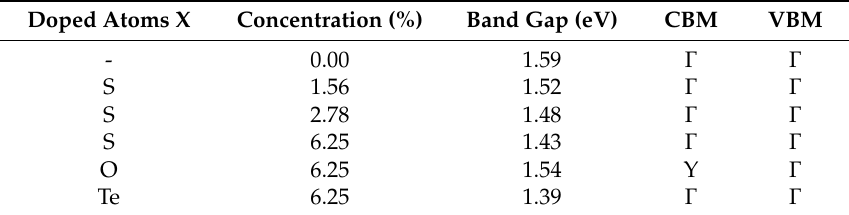
Table 2. Band gaps of monolayer CSe with and without